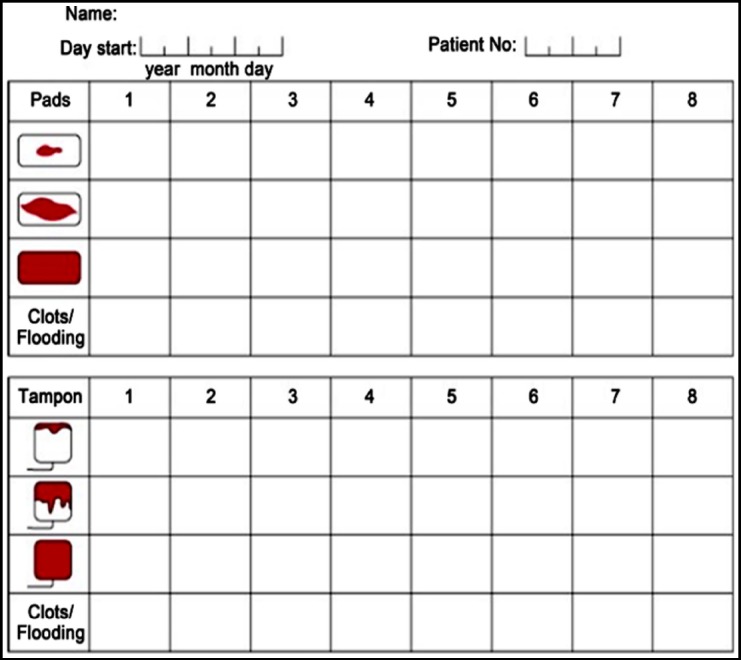
The Pictorial Bleeding Assessment Chart (PBAC).